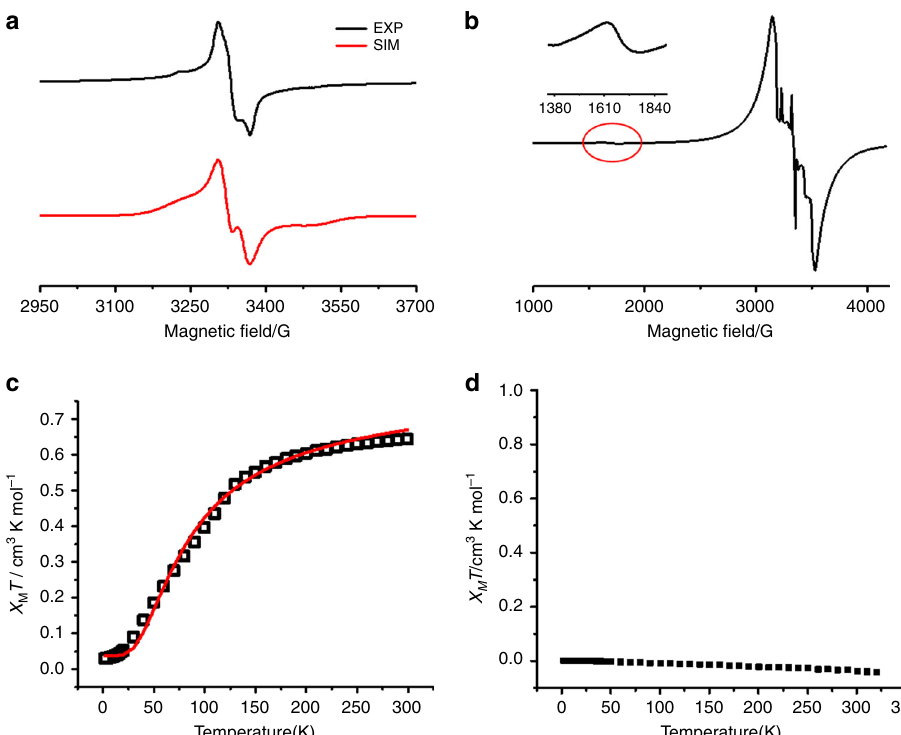
Fig. 4 EPR spectra and temperature-dependent plots of χ M T for the crystals of 2 2 + . a The EPR spectrum of frozen solution of 2 2 + (1 × 10 − 4 mol/l) at 183 K (in black) with simulation (in red). b The EPR spectrum of the powder sample of 2 2 + at 183 K with the forbidden transition at the half magnetic fi eld. c Temperature-dependent plots of χ M T for the crystals of 2 2 + from 2 to 320 K (in black) with the fi tting plot via the Bleaney – Bowers equation (in red). d Temperature-dependent plots of χ M T for the crystals of 1 2 + from 2 to 320 K.